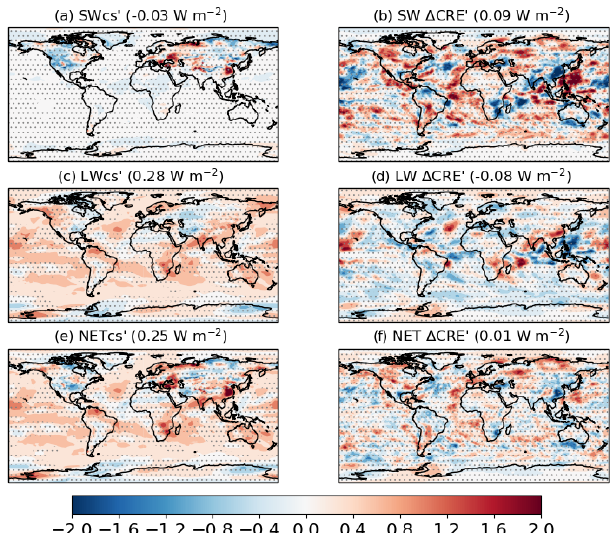
Figure 4. Global distributions of the PD N 2 O ERF components relative to the PI period, i.e. piClim-N2O minus piClim-control ; (a) SW (cid:48) cs , (b) SW CRE (cid:48) , (c) LW (cid:48) cs , (d) LW CRE (cid:48) , (e) NET (cid:48) cs , and (f) NET CRE (cid:48) , based on Eq. (8). Global mean values are shown in brackets. Regions where the ERF components are outside the 95% confidence level are stippled. Units in Wm − 2 .